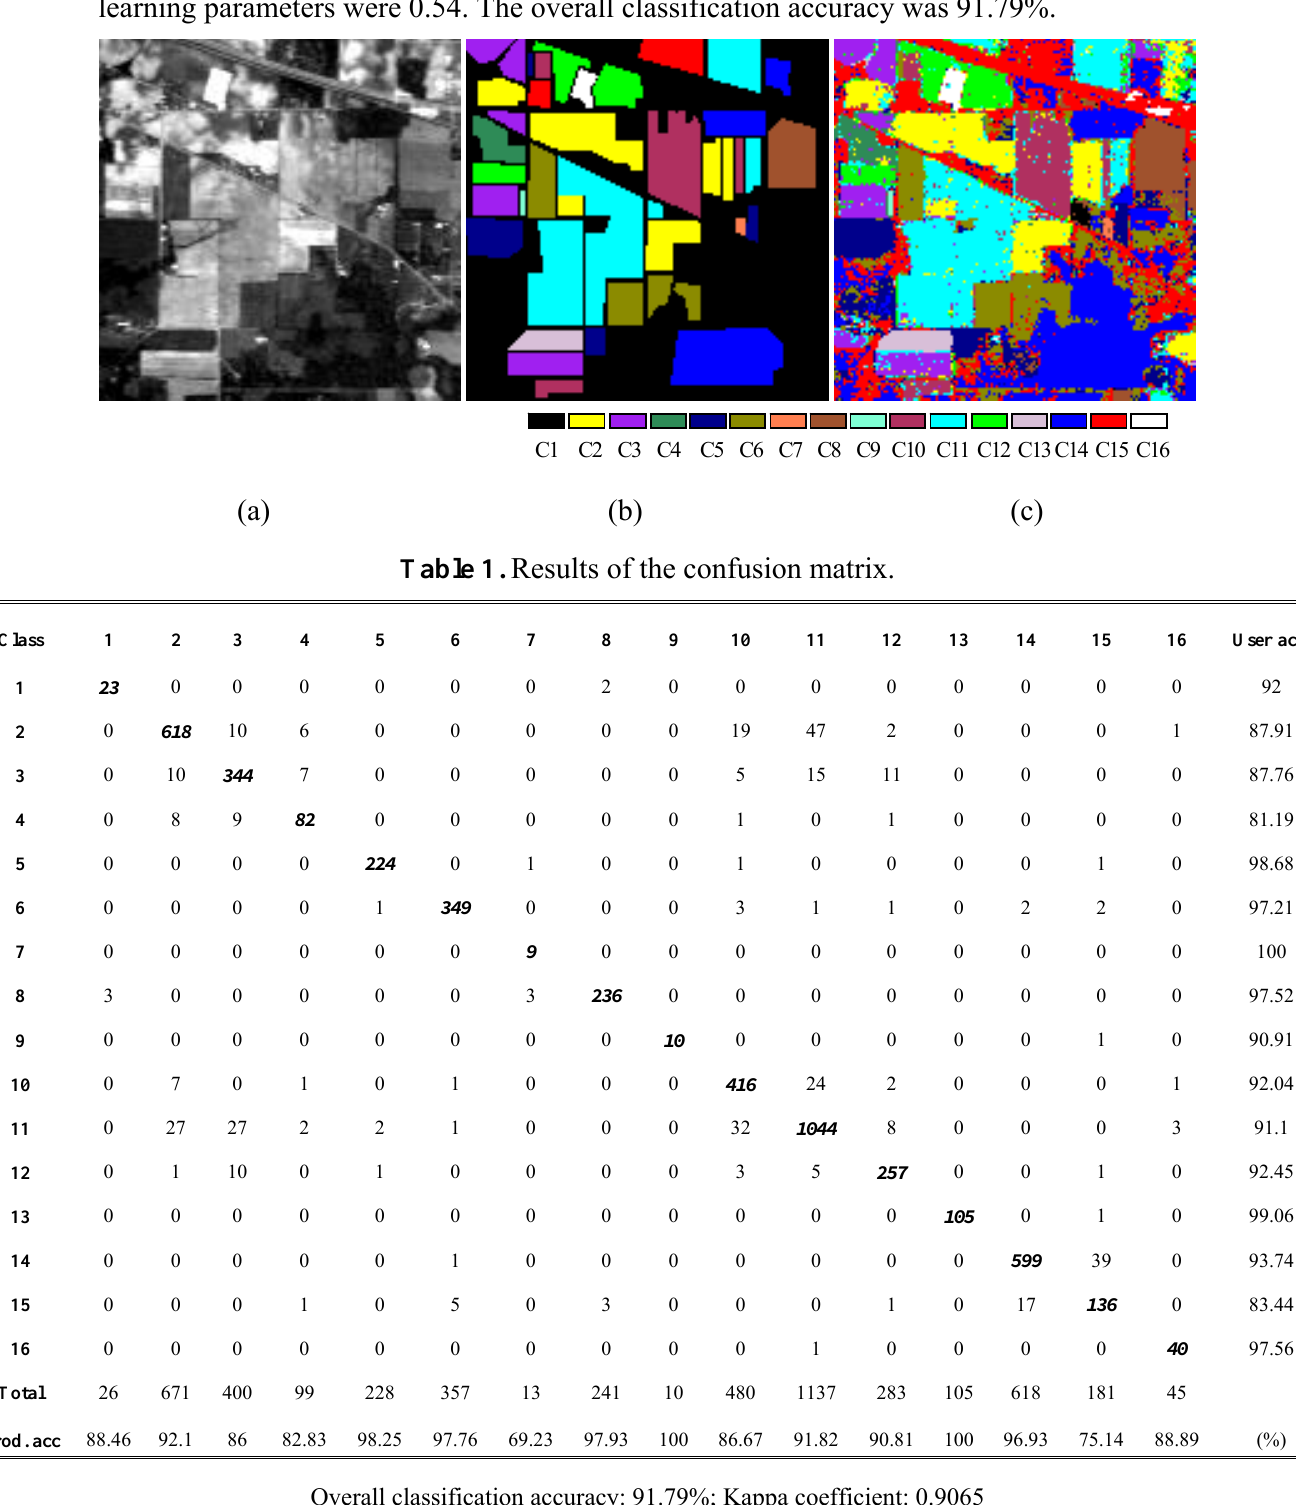
Overall classification accuracy: 91.79%; Kappa coefficient: